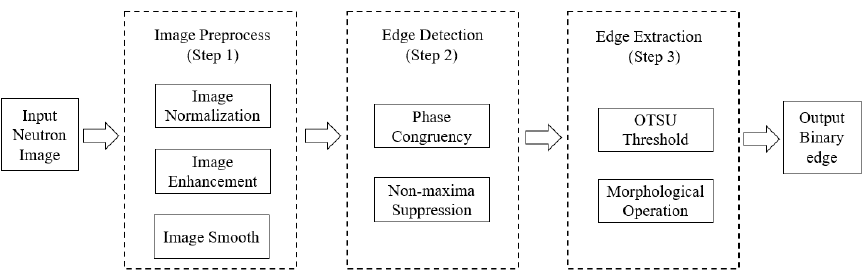
Figure 4. Block diagram of the proposed edge-detection method.